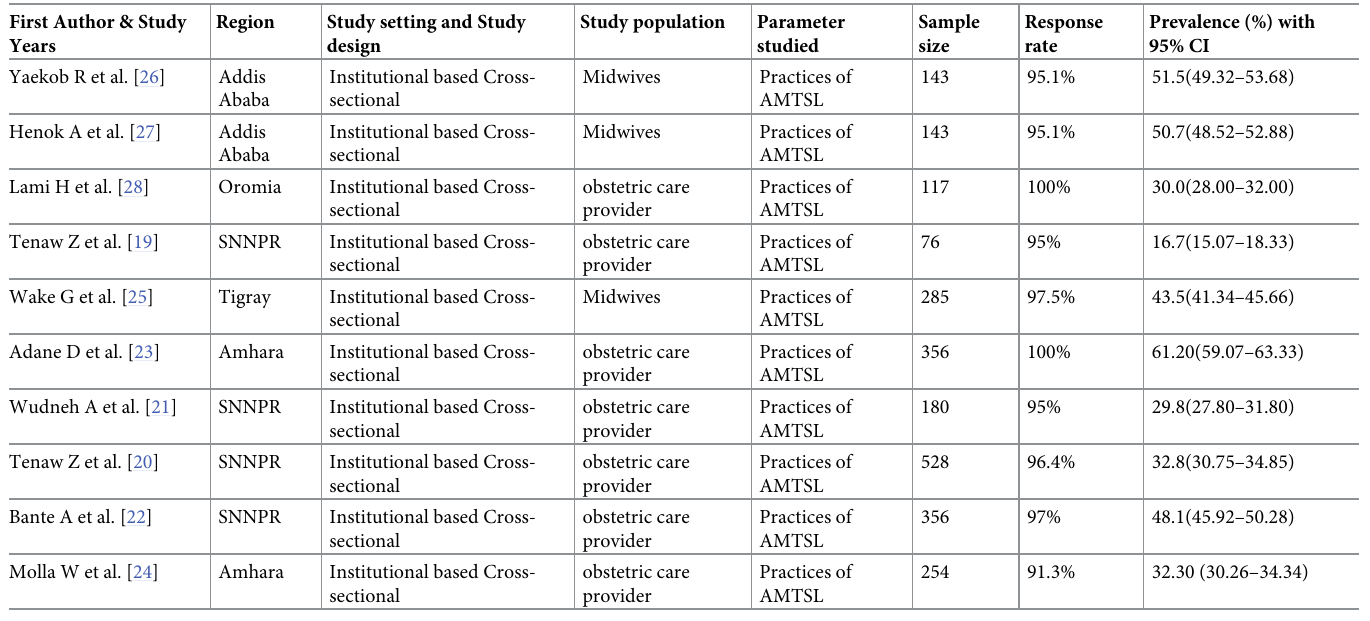
Table 1. Characteristics of included studies reporting the prevalence of practices of active management of the third stage of labor in Ethiopia, 2010 to